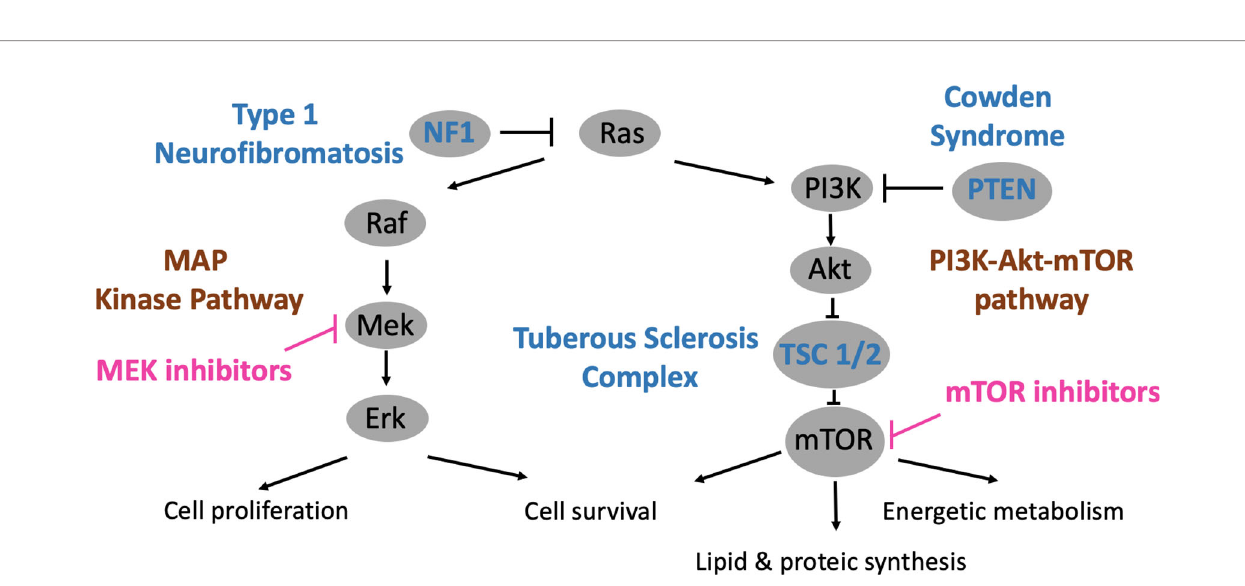
FIGURE 2 | PI3K-Akt-mTOR and MAP kinase pathways, relations with phakomatoses (TSC, NF1 and CS) and therapeutic developments.